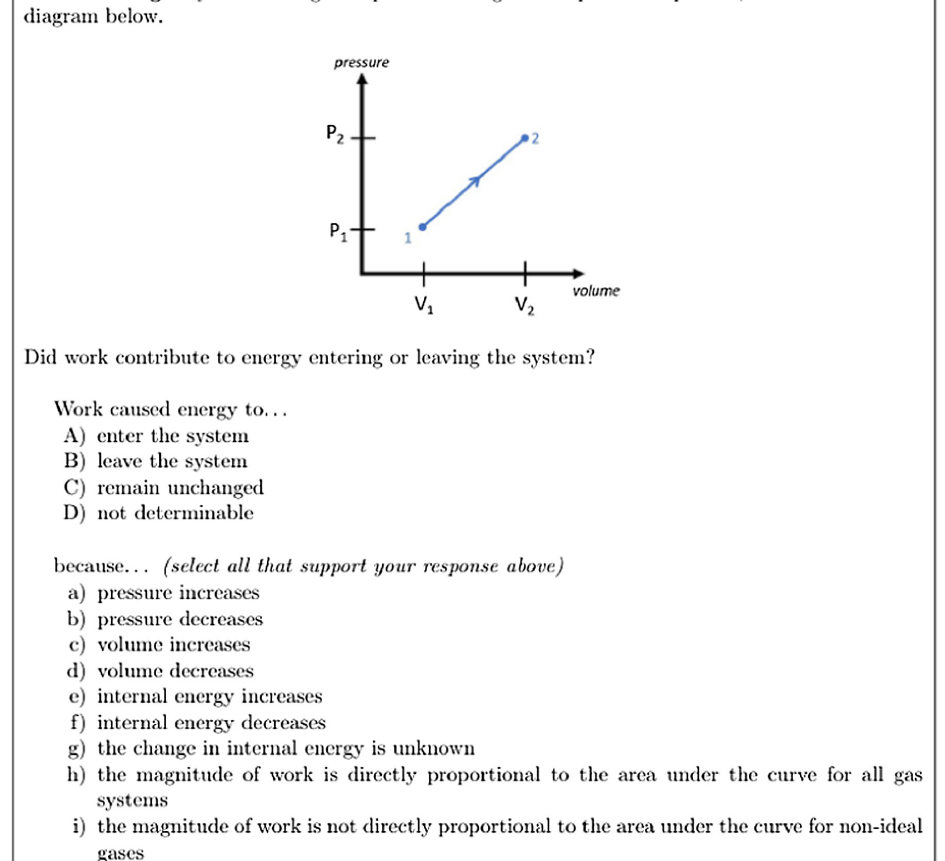
FIG. 1. A CMR item included on the U-STEP addressing the concept of work (item 1). The item is composed of a multiple choice (MC) prompt, followed by a prompt for reasoning. The MC portion of the item asks only for direction of energy flow due to work, as opposed to the sign of work, to accommodate for different sign conventions used across different classes (i.e., based on defining work as done on or by the system). Note that “ not determinable ” was included here to account for the possibility that, for example, a student believes that the fact that this gas is nonideal means we cannot determine work from a P-V